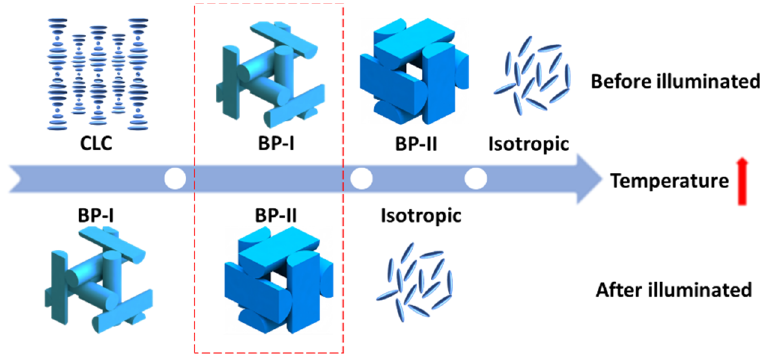
Figure 4. R-POM images of the aligned CA-BPLC sample during the illumination of 405 nm laser for ( a ) 0, ( b ) 28, ( c ) 40, ( d ) 82, and ( e ) 120 s at BPI. The length of the scale bar is 100 μ m. ( f ) The variation in the reflection wavelength of the aligned CA-BPLC sample at BPI with increasing illumination time of 405 nm laser. The temperature is fixed at 46.5 °C.